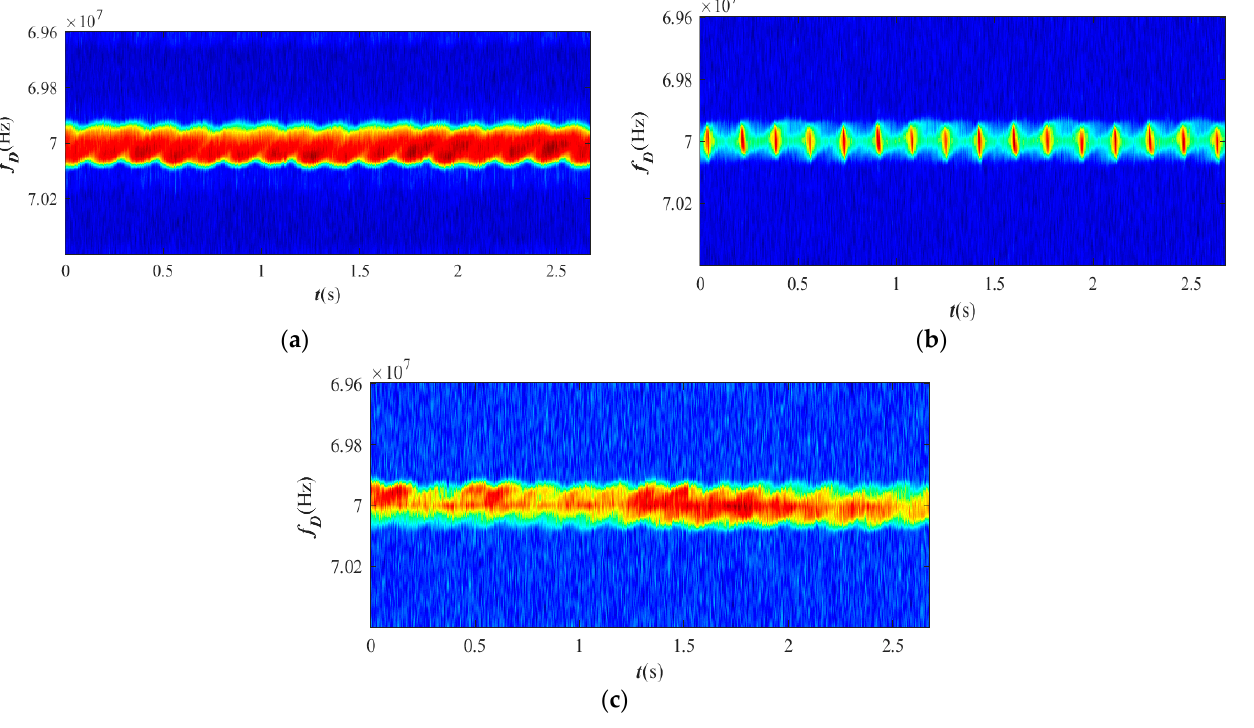
Figure 9. TF diagrams of cube target with surface made of different materials. ( a ) Resin. ( b ) Aluminum alloy. ( c ) Fiber-reinforced polymer.